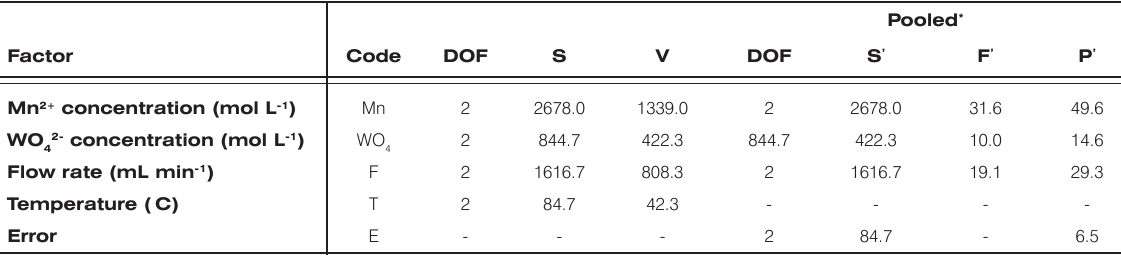
(3 4 ) matrix while diameters of synthesized MnWO 9 Pooled